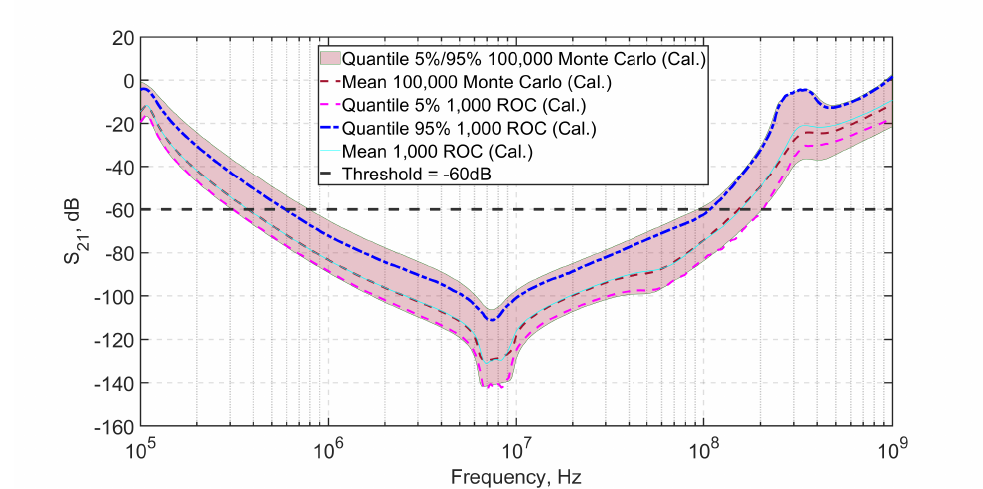
Figure 21. Filtering performances: 5%/95% confidence intervals from Test case #2/Channel #1 including MC samples and ROC calculations.